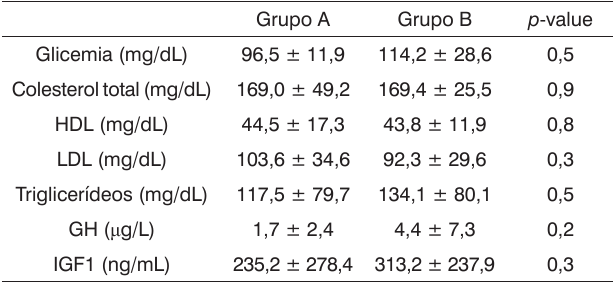
Tabela 2. Parâmetros bioquímicos dos pacientes com acromegalia dos grupos A e B.